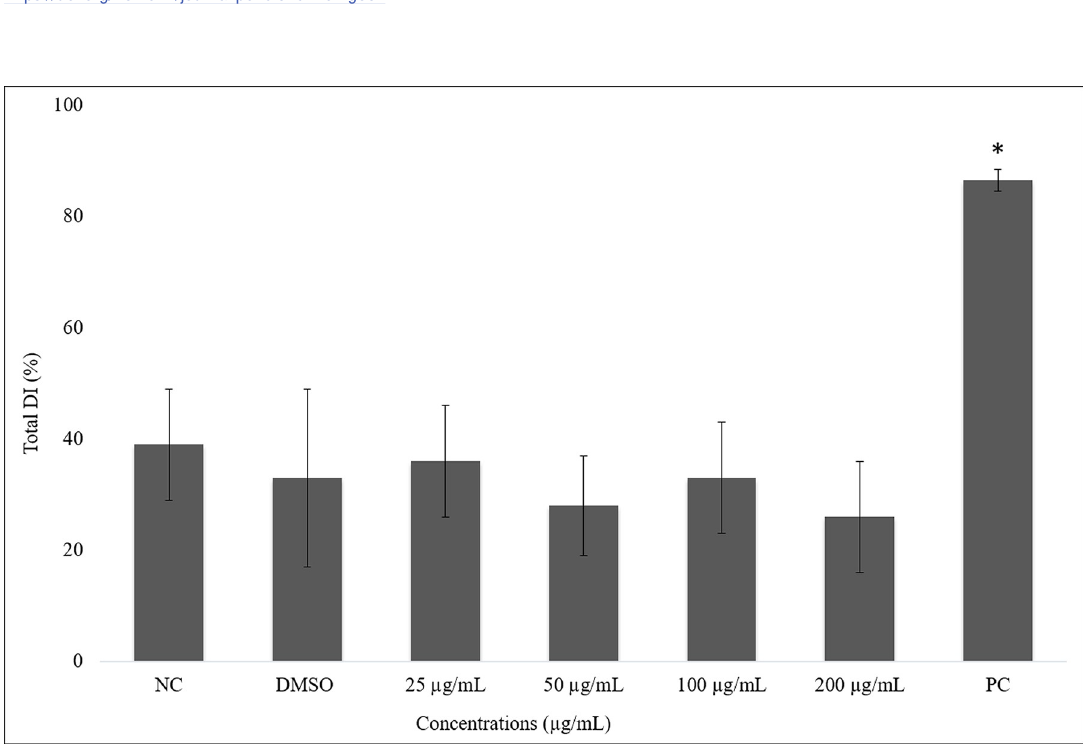
Fig 3. Percentage of average of total damage index in ACP02 cells after 23 hours of exposure to juca aqueous ethanol extract and it controls. ANOVA parametric test; Tukey-Kramer Multiple comparisons (p < 0.05); NC means negative control, PC means positive control and � Differs from other